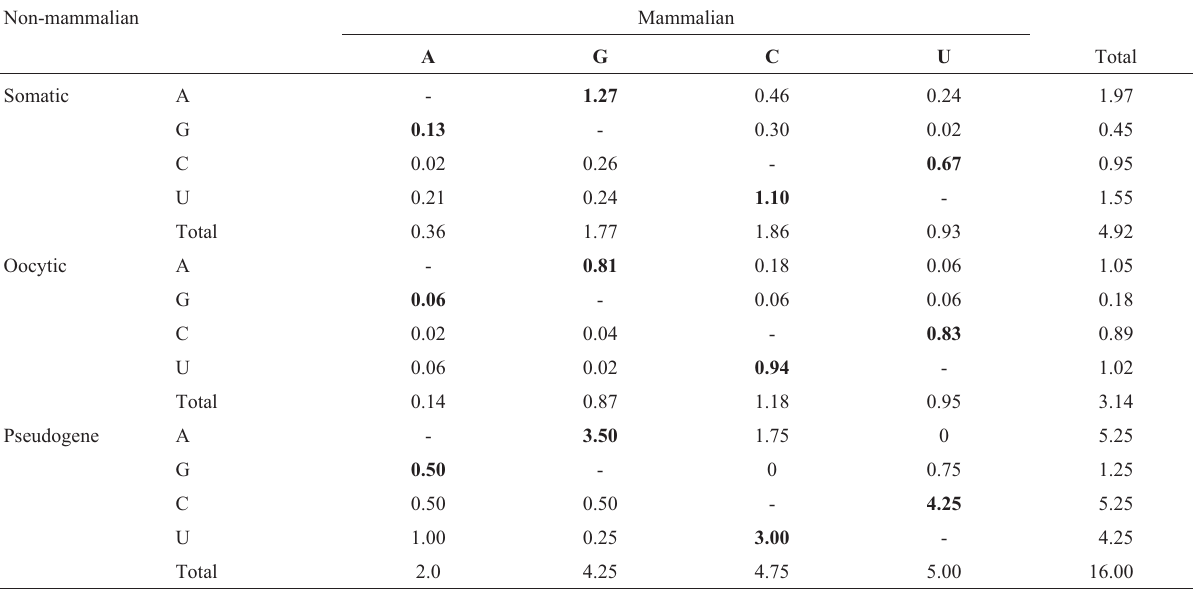
Table III - Base substitutions in the 5S rRNA of deuterostomes. Non-mammalian